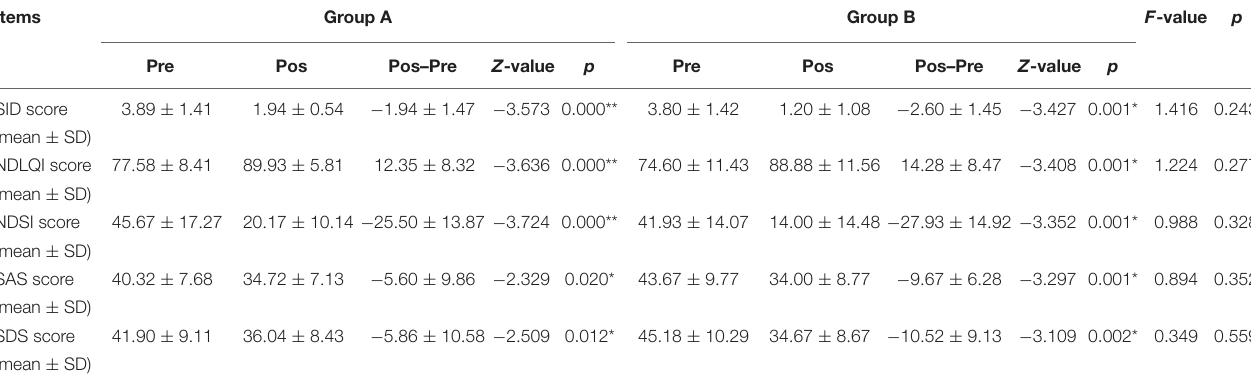
TABLE 2 | Comparison of the therapeutic effects between group A and group B. Items Group A Group B